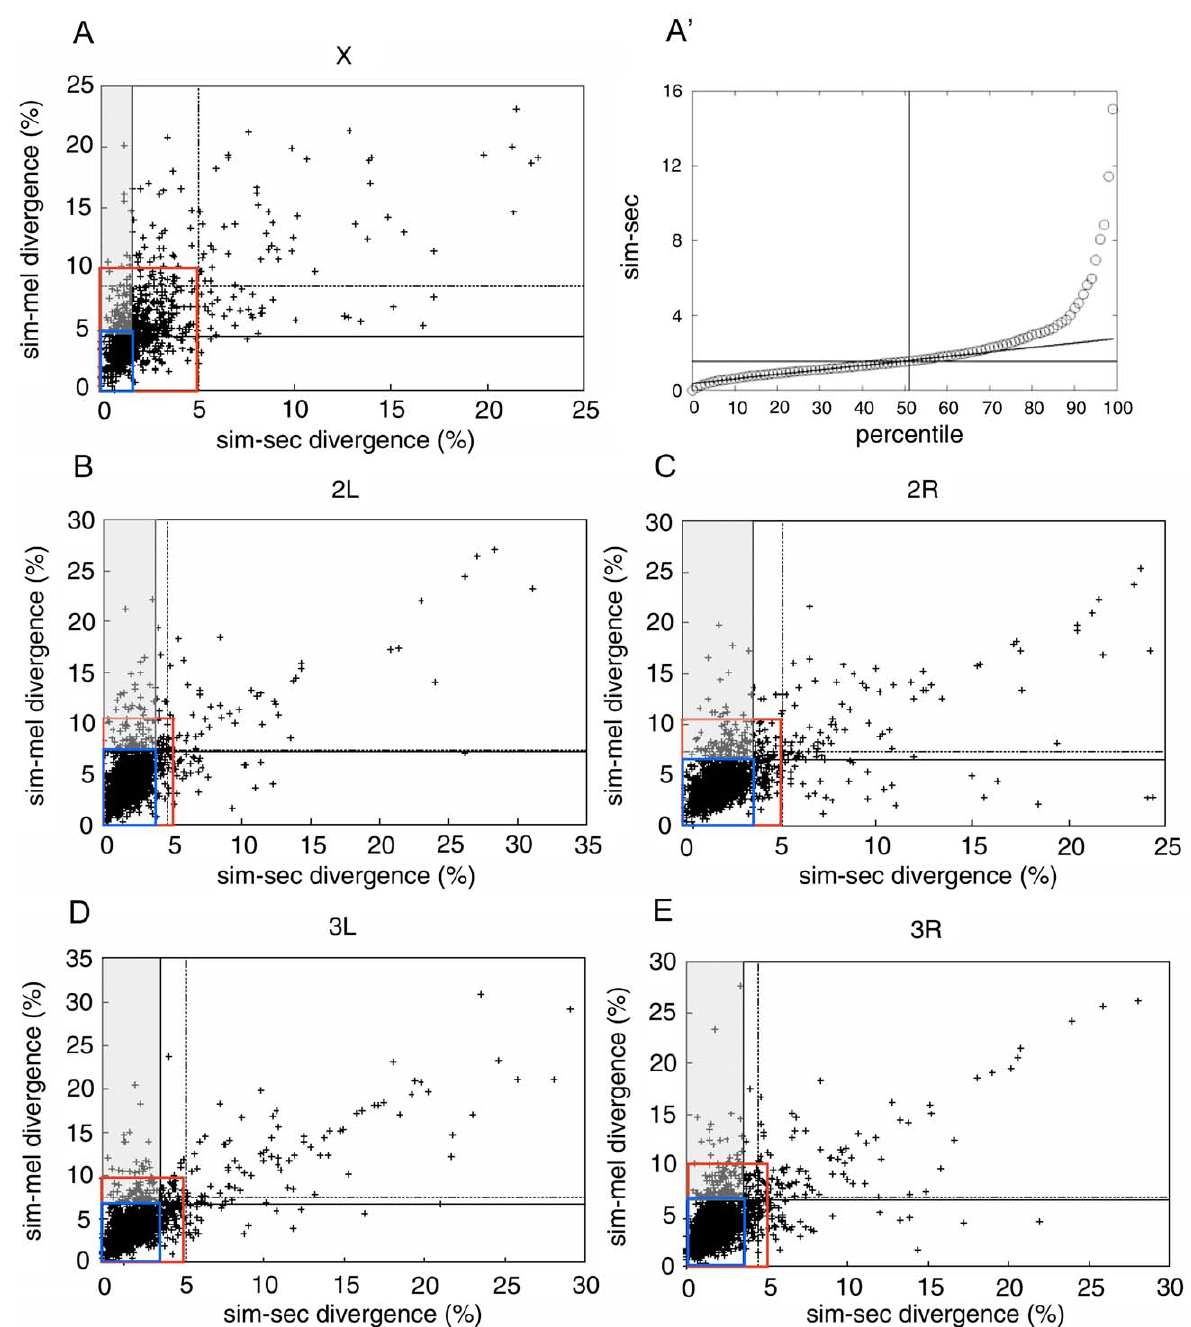
Figure 2. Patterns of divergence along chromosomes and two screening methods. A, B, C, D and E) Each graph corresponds to a chromosome or chromosome arm (X, 2L, 2R, 3L and 3R), where the genes are ordered from the least divergent to the most divergent in sim-sec (abscissa) and sim-mel (ordinate). The horizontal and vertical dashed lines delimit the averages plus one standard deviation of the divergence between sim-sec (horizontal) and sim-mel (vertical). The upper left quadrants delimit genes found by the method of averages and standard deviations. Note that the divergences of most genes in all 5 graphs are clustered in a quadrant that can be roughly delimited between the abscissa values of 0%–5% and ordinate values 0%–10% (red rectangles). In this quadrant, the genes have a good fit with a linear distribution (P , 0.0001). To better delimit the quadrant in which the divergence is linear in each chromosome, the data was divided in percentiles of divergences of sim-sec, sim- mel and sec-mel. (A’) exemplifies the percentiles of the X chromosome. Since each point in these curves represents one percentile, the percentage of genes that diverge linearly is equal to the number of points that can be transected by a straight line. Once this linear interval is defined, the values on the x and y axes become known and can be used to redefine the quadrant of linear divergences (inferior left quadrant in blue). The region where the genes in sim-sec vary the least and the genes in sim-mel vary the most is the adjacent upper quadrant to the left of the point where the horizontal and vertical lines cross (gray quadrant).